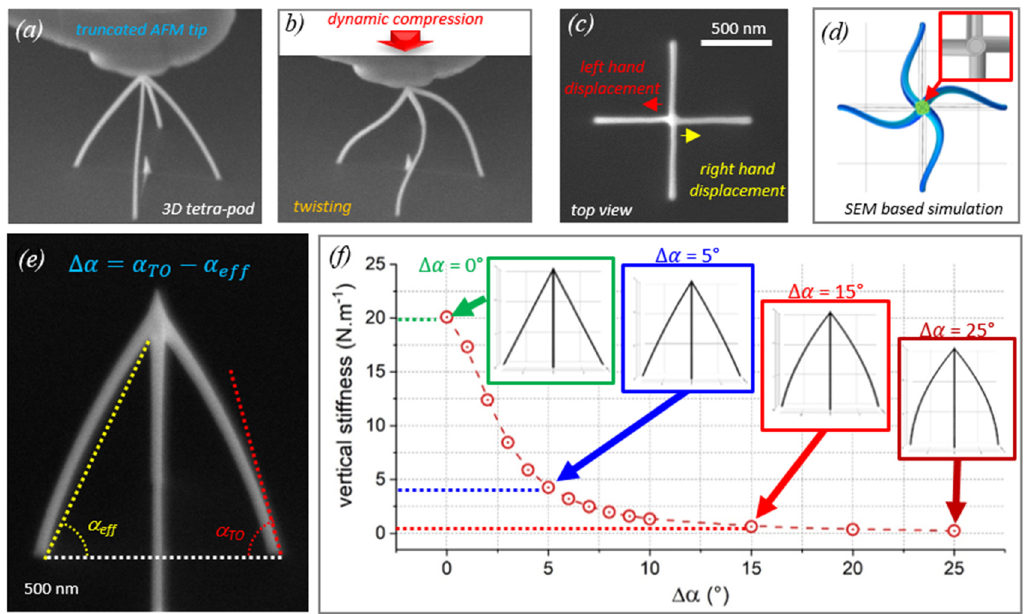
Figure 26. Nanofabrication-related implications on mechanical properties. ( a ) shows an SEM side-view of a Pt-C tetrapod fabricated via 3D FEBID on SiO 2 . The upper part is a truncated AFM tip, which allows dynamic compression of such nanoarchitectures. The latter is shown in ( b ), where unexpected twisting effects were stochastically found. The SEM top view image in ( c ) reveals slight mismatches in the merging zone by left/right-handed displacements in the sub-10 nm regime (see arrows). ( d ) shows a finite-element simulation during vertical compression, including the aforementioned displacement as shown in the red-framed inset. This mismatch, although small, induce the twisting effect, which clearly shows the high demands on spatial precision during 3D nanofabrication. ( e ) shows another tetrapod structure in an SEM side view, in which the non-straight branches become evident. For further studies, Δα was defined as indicated in blue. Then, this parameter was varied in finite-element simulations, while vertical stiffnesses were calculated as shown in ( f ) and further validated by experiments (see ref [128] ). As evident, even a small Δα of 5° implies a four-fold decrease in stiffness, which decays quickly with larger Δα . As for the upper row, these experiments reveal the high demands on nanofabrication to fully exploit the intended mechanical properties. Images were reproduced with permission from reference [128] .